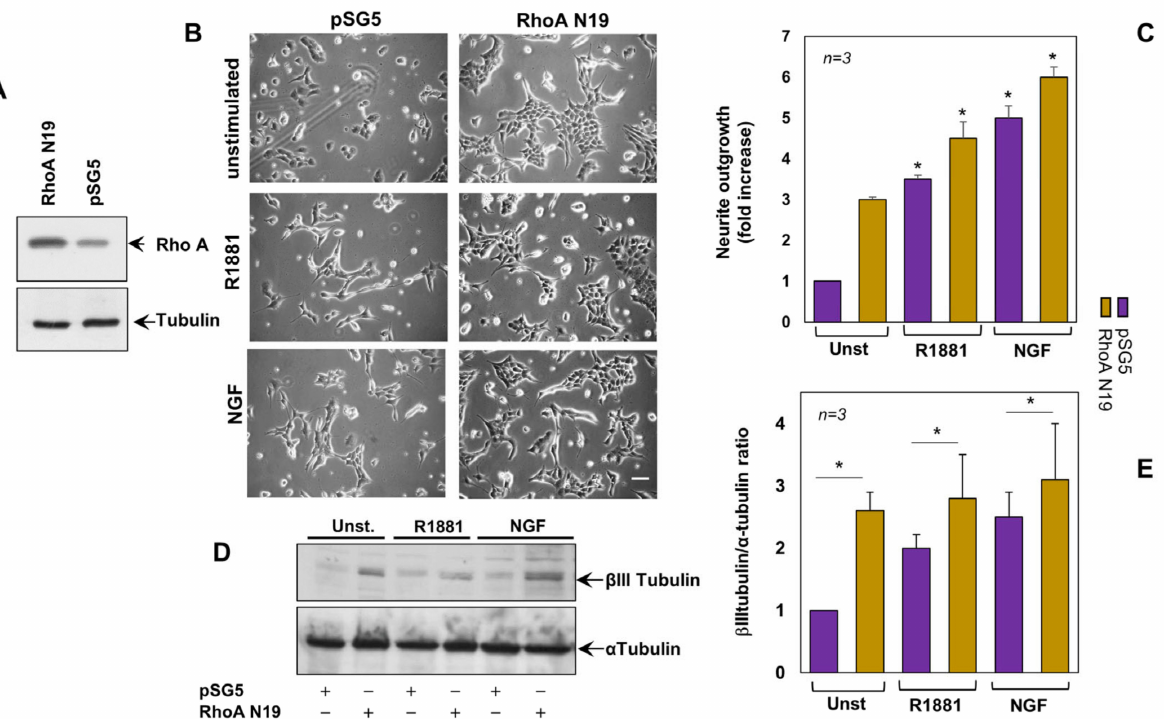
Figure 2. Expression of the dominant negative RhoA (RhoA N19) induces neurite outgrowth. ( A ), PC12 cells, transiently transfected with RhoA N19 construct or the empty plasmid pSG5, were untreated or treated for 24 h with R1881 or NGF and neurite outgrowth was analyzed by contrast phase microscopy ( B ). Bar, 10 µ M. In ( C ), the neurite outgrowth was expressed as fold increase over the basal level, which corresponds to unstimulated cells transfected with pSG5. It was significant (* p < 0.05) for the indicated experimental points vs the corresponding unstimulated cells. Lysate proteins from transfected cells were analyzed for β III or α tubulin expression ( D ). Protein amounts in ( D ) were quantified by NIH Image J software and graphically shown as β III/ α tubulin ratio ( E ). * p < 0.05. In ( C , E ), means and SEMs are shown. n indicates the number of